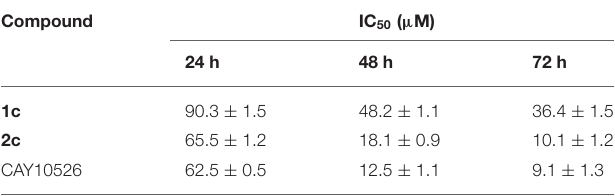
TABLE 2 | Cell viability assay of mPGES-1 inhibitors in the A549 cancer cell line. Compound IC 50 ( µ M) 24 h 48 h 72